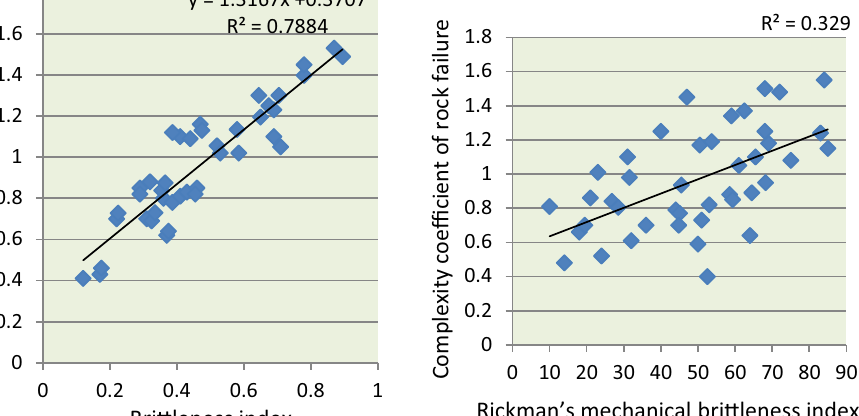
Fig. 13 Relationship between brittleness index and complexity of rock failure